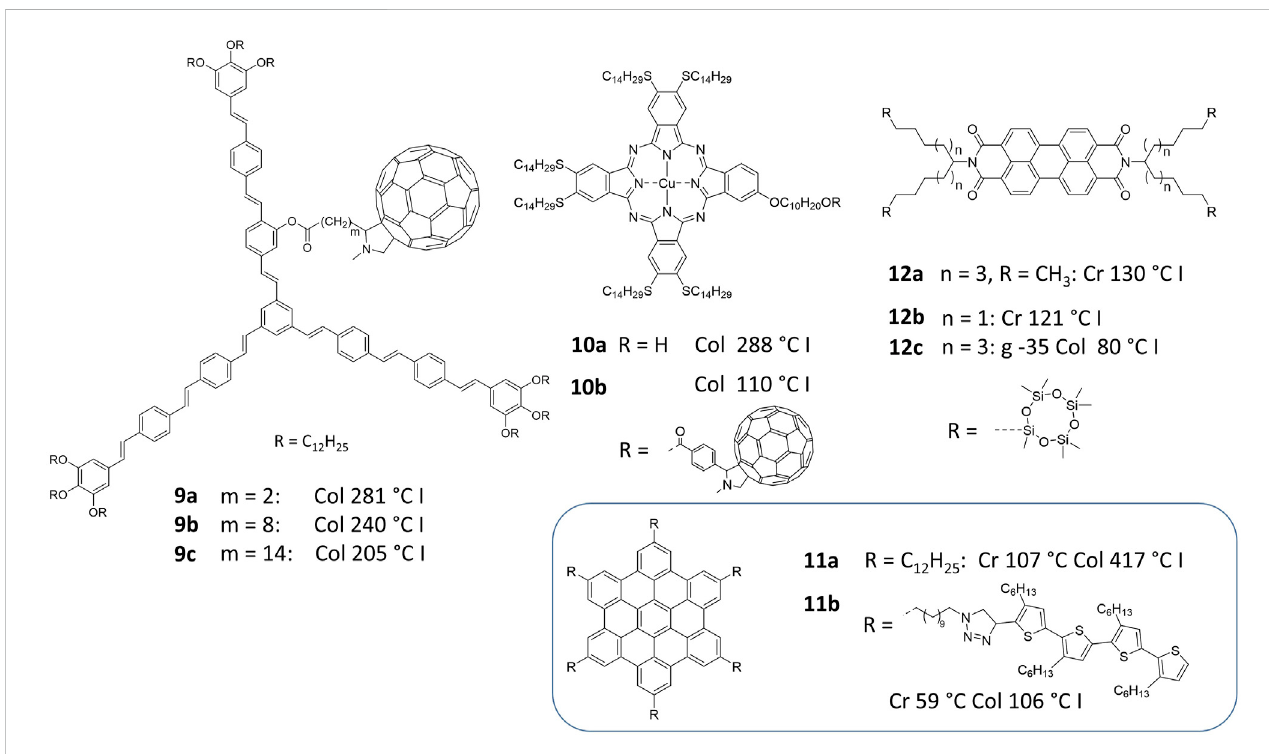
FIGURE 2 The transition entropy strategy – double nanosegregated structures linked by fl exible